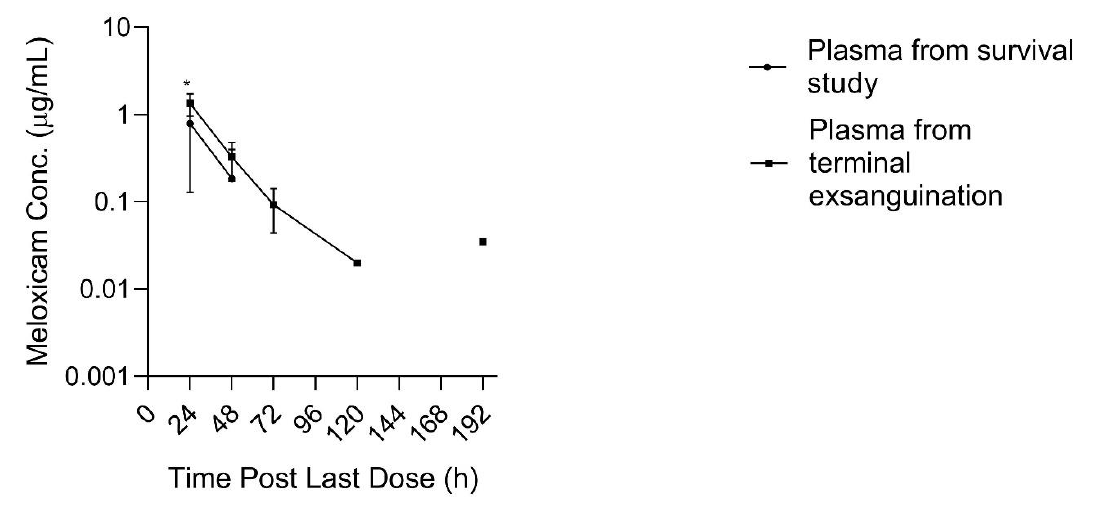
Figure 5. Plasma sample meloxicam concentrations (+SD) after 10 daily oral 1 mg/kg doses obtained either via live animal phlebotomy in a survival PK study or at time of terminal exsanguination and tissue collection in a tissue depletion study. Live animal phlebotomy n = 6; terminal exsanguination n = 3 per time point, 21 sheep total. Data points below the LLOQ excluded. No meloxicam was detected in any plasma samples in the live animal study at 120,144 and 192 h. Significant difference between groups at 24 h indicated by an * ( p = 0.045).